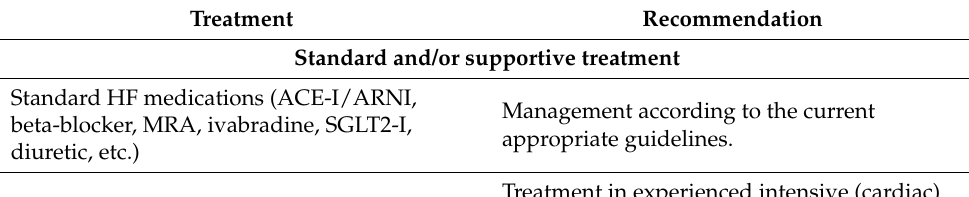
Table 3. Personalized treatment regimens for patients with myocarditis/inflammatory